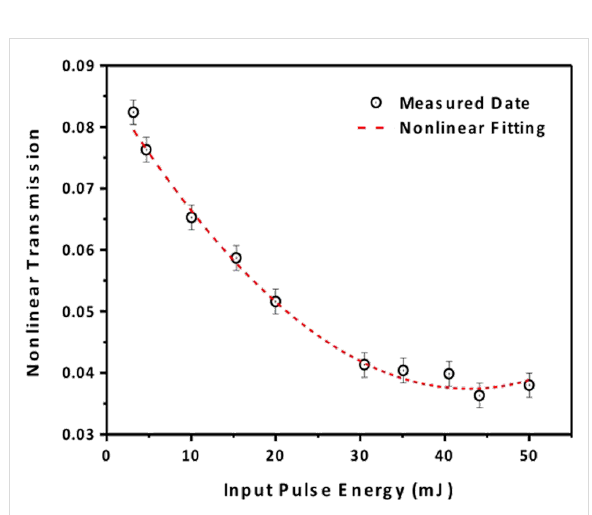
Figure 5: Measured nonlinear transmission versus the input pulse energy for Ag 2 S QDs. The dashed line represents the best fitting curve based on Equation 3 with β =